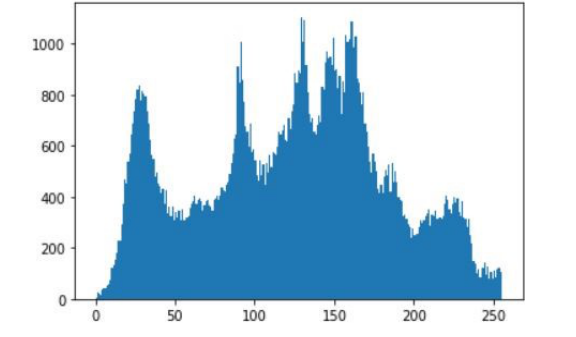
Figure 12. Histogram of original image of LENA